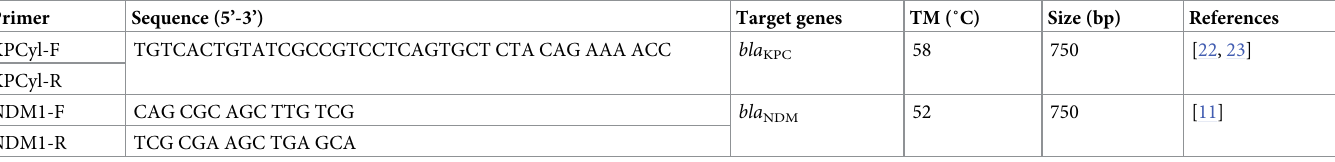
Table 1. Primers encoding for